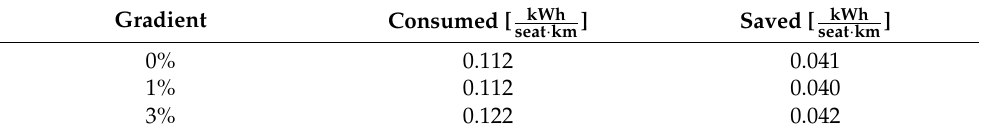
Table 6. Energy per seat per kilometer. Top speed 31.25